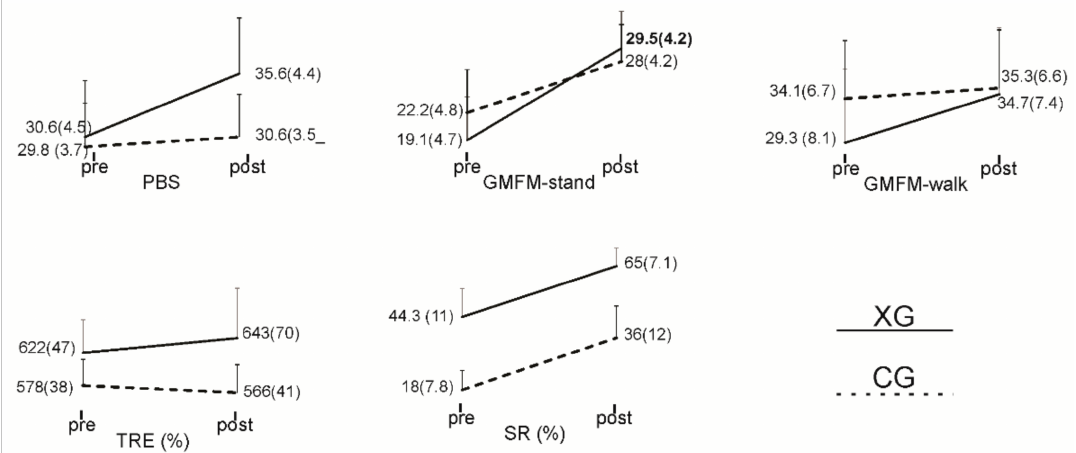
Figure 3. Lineplotspresentinggroupmeansandstandarderrorsofmeans(SEM)pre-andpost-intervention.